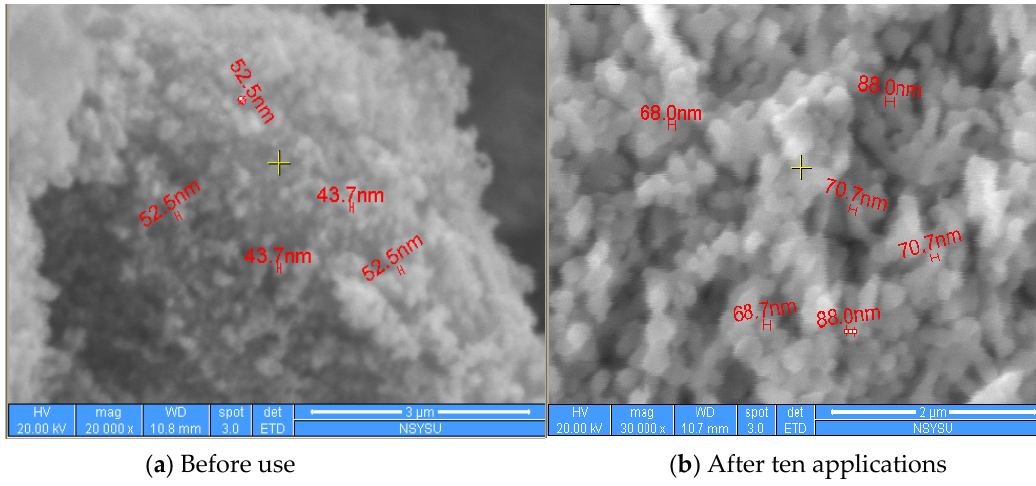
Figure 3. The material structure of the catalyst, captured by the Environmental Scanning Electron Microscope (ESEM). Plot ( a ) represents the initial size of the grain was between 40 nm and 55 nm. Plot ( b ) shows the grain size increased to between 65 nm and 90 nm after repeated